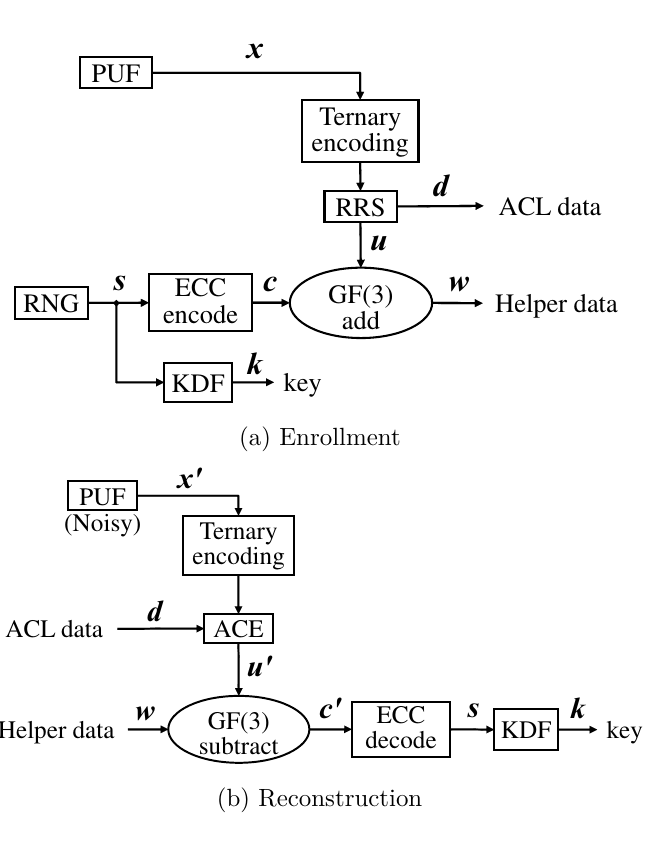
Figure 9: Block diagram of ternary AR-based